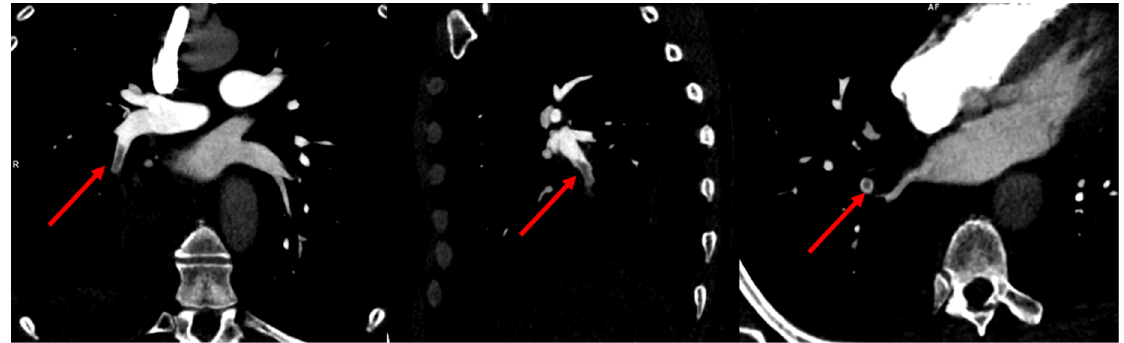
Figure 2. Multiplanar reformat views of CTPA showing a segmental filling defect in a segmental artery of the right lower lobe.